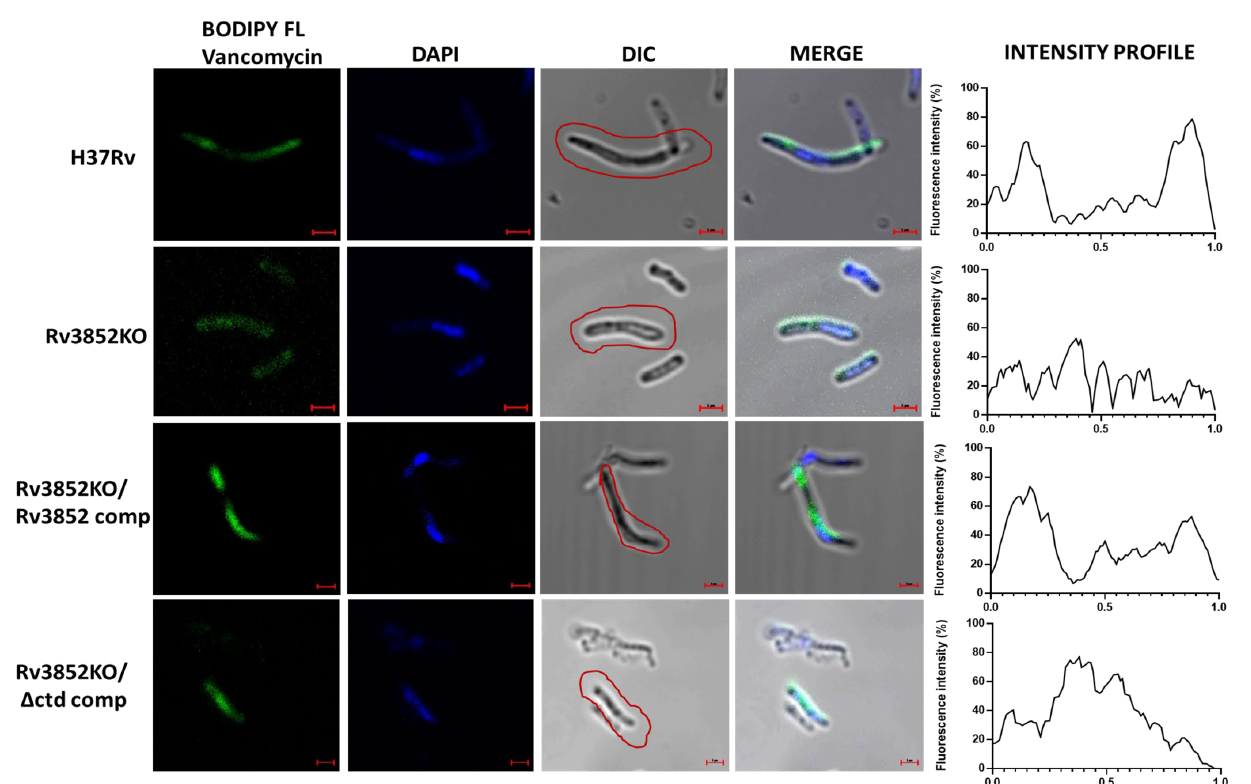
Figure 7. Absence of Rv3852 affected nascent peptidoglycan synthesis. Representative confocal images of BODIPY FL Vancomycin staining of Mtb H37Rv, Rv3852KO, Rv3852KO/Rv3852 comp, and Rv3852KO/ ∆ ctd comp strains. Red boundaries indicate the cells taken for intensity profile measurement shown in the last lane of each panel. Bacterial length is normalized to 1, and the fluorescence intensity is shown as percentage of highest intensity. The curve was smoothed using Graph Pad Prism 6.0. The merge lane shows merged image of all channels. The images were acquired using a Zeiss LSM880 microscope under 100 × objective with 2 × zoom. Scale bar indicates 1 µ m. See Figure S8 for fluorescence intensity distribution